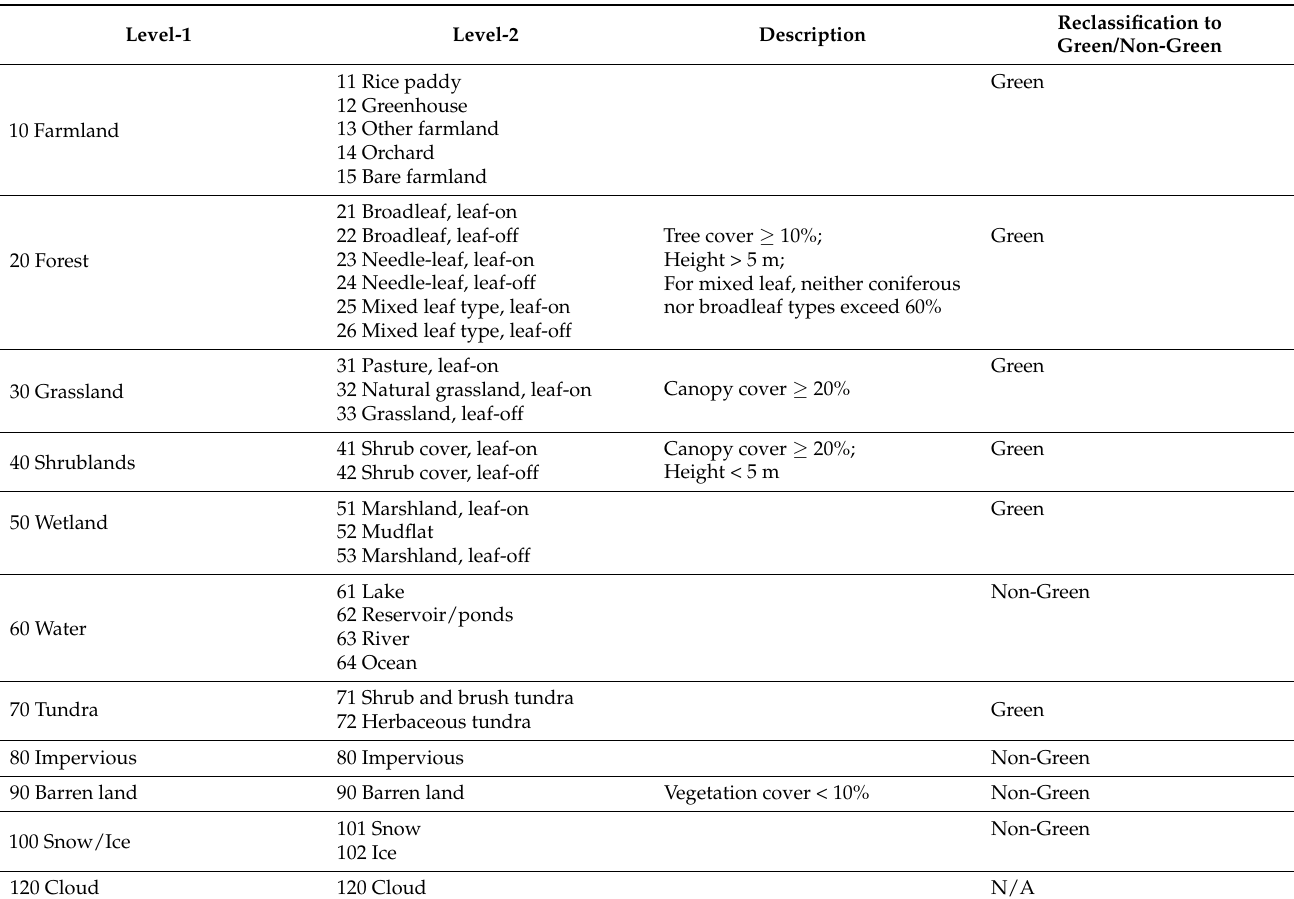
Table A2. Land cover classes included in training dataset developed by Li et al.